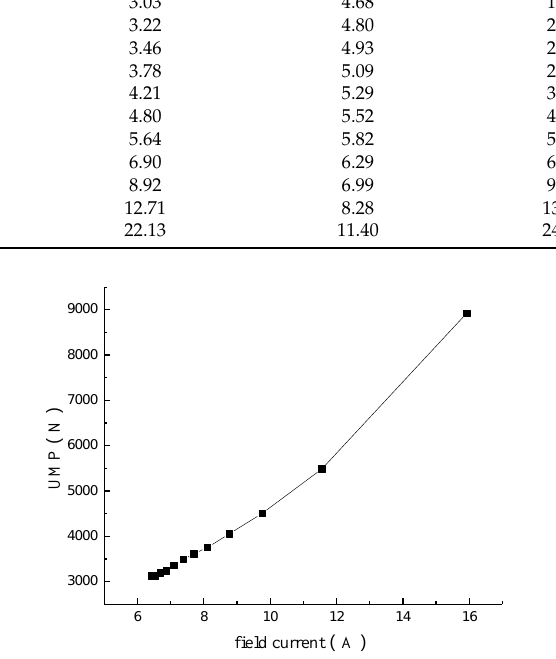
Figure 17. Relationship between UMP and field current.